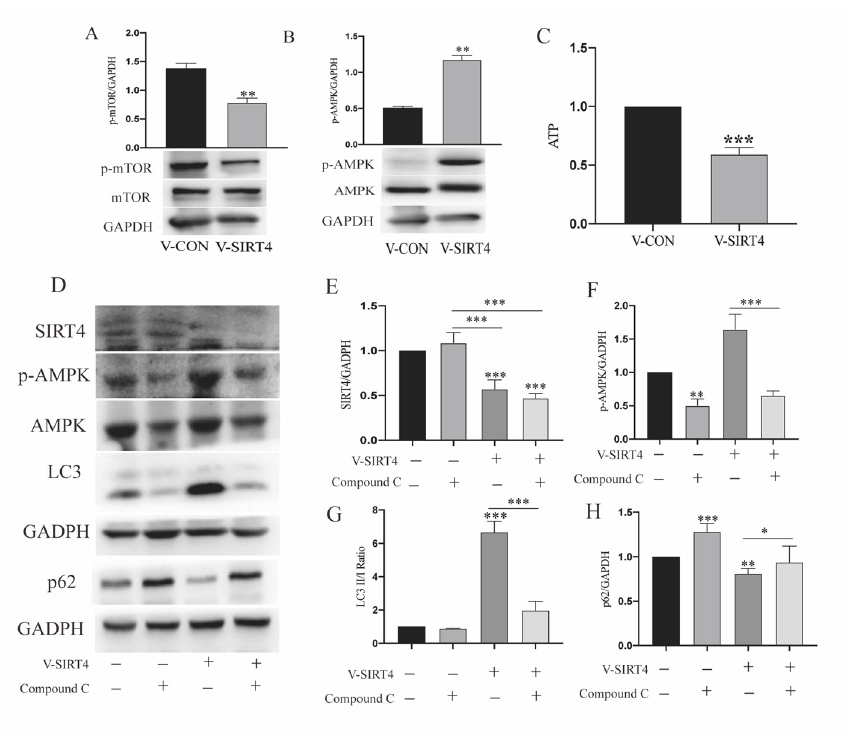
Figure 7. SIRT4 participates in modulating r-MC autophagic function through AMPK/mTOR sig- naling pathway. ( A , B ) Protein expression levels of p-AMPK and p-mTOR in whole-cell lysates from cells transfected with V-SIRT4 ( n = 4 per group; ** p < 0.01). ( C ) ATP generation of MGCs transfected with V-SIRT4. Data are shown as means ± SEMs ( n = 3 per group; *** p < 0.001). ( D – H ) Protein ex- pression levels of SIRT4, p-AMPK, p-mTOR, LC3, and SQSTM1/p62 in whole-cell lysates from cells transfected with V-SIRT4 and treated with compound C (n = 3 per group; * p < 0.05, ** p < 0.01, and *** p < 0.001). p62, SQSTM1/p62.